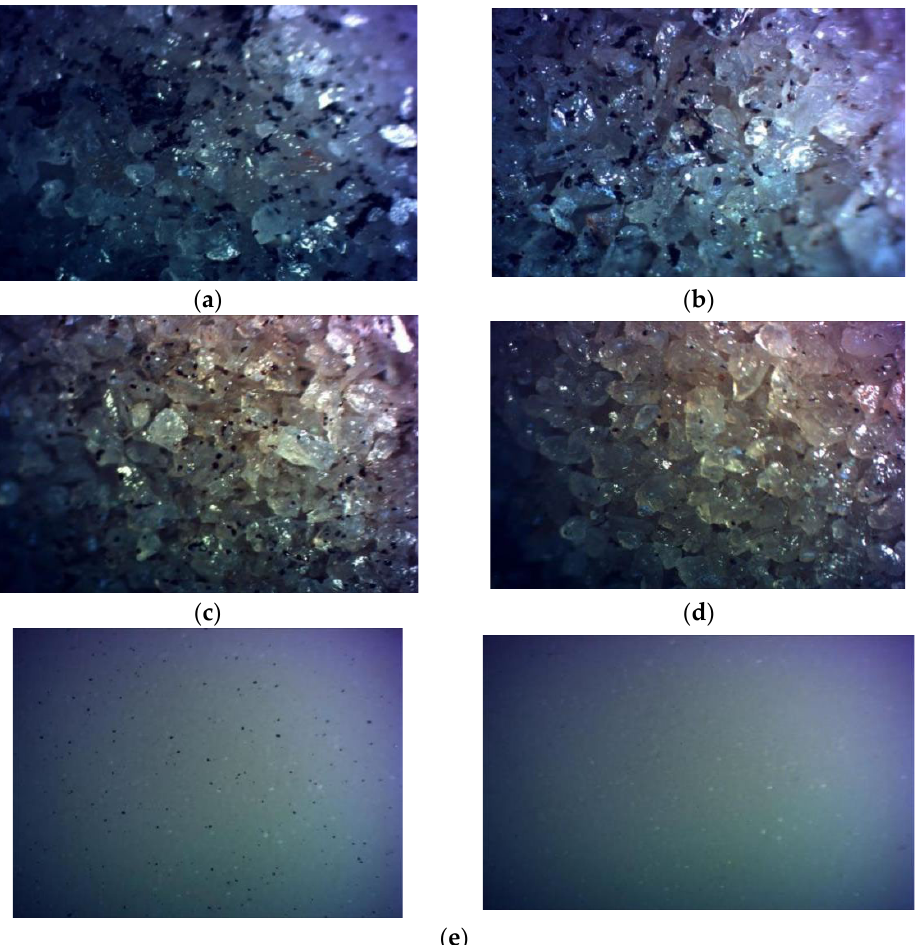
Figure 12. Fracture interior and produced fluid characteristics. ( a ) Injection end (before flushing), ( b ) Outlet end (before scouring), ( c ) Injection end (after flushing), ( d ) Outlet end (after scouring), ( e ) Solid suspension in produced liquid.